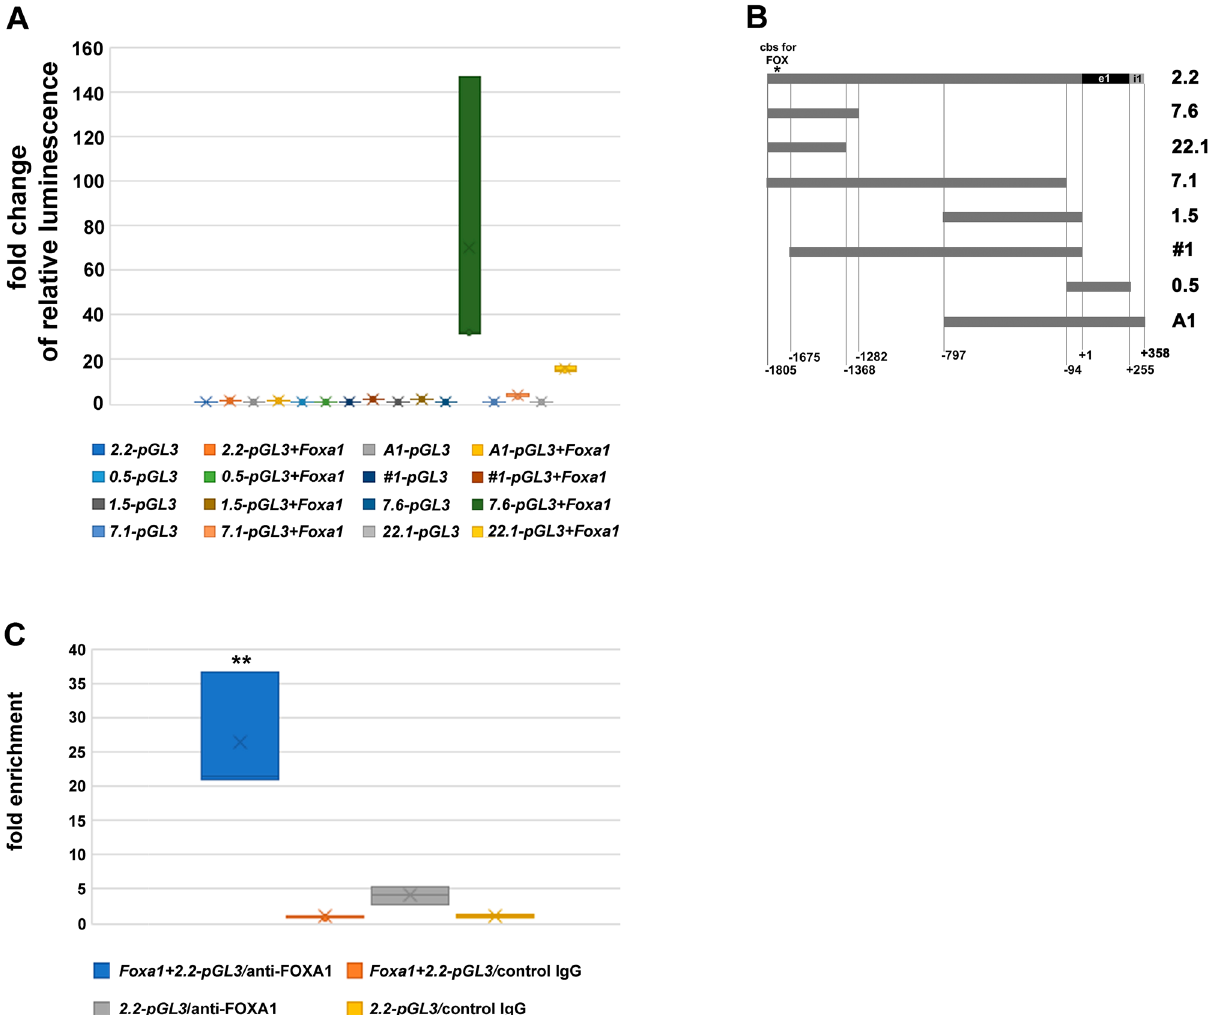
Figure 4. FOXA1 binds to the sequence TGT TTA C situated at positions -1768 to -1775 of the Odf2 promoter. ( A ) Reporter gene assay to narrow down the FOXA1-binding site. Reporter vectors comprising specific parts of the Odf2 promoter were investigated for their activation by FOXA1. FOXA1-mediated transcriptional activation was always related to that of the respective vector, without FOXA1 co-expression. The strongest activation was observed for the reporter vectors 7.6 (~ 70x), 22.1 (~ 16x), and 7.1 (~ 4x) indicating that the FOXA1-binding site is positioned in the region − 1282 to − 1805. Three biological replicates. ( B ) Scheme of the Odf2 promoter fragments cloned upstream of the firefly reporter gene (e1 = exon1, i1 = intron1). The consensus binding site (cbs) for FOX TFs is located at position − 1768 to − 1775 (*). ( C ) Chromatin immune-precipitation by FOXA1 and qPCR of the binding-site sequence revealed significant enrichment. NIH3T3 cells were transfected with the Odf2 promoter reporter vector 2.2-pGL3 as bait. Co-transfection of the Foxa1 expression plasmid ( Foxa1 + 2.2- pGL3 /anti-FOXA1) resulted in an ~ 26 × enrichment of the FOXA1-binding site compared to the control IgGs ( Foxa1 + 2.2-pGL3 /control IgG) ( p **, p = 0.007838). Precipitation of the endogenous FOXA1 by anti-FOXA1 antibodies ( 2.2-pGL3 /anti-FOXA1) caused an ~ 4 × enrichment of the binding sequence compared to the control ( 2.2-pGL3 /control IgG) that is, however, not significant ( p = Foxa1 siRNA‑mediated knockdown affects the endogenous expression of Foxa1 , Odf2 /ODF2, and CP110. Having proven an efficient reduction of FOXA1 protein by Foxa1 siRNA-mediated knockdown, we asked whether knockdown of Foxa1 could also be detected at the endogenous transcript level and whether a knockdown of FOXA1 would be accompanied by a reduction of Odf2 transcripts and also of ODF2 proteins. NIH3T3 cells were, thus, transfected with the Foxa1 siRNA, and transcripts of Foxa1 and Odf2 were quantified by qRT-PCR. We observed a reduction of Foxa1 transcripts in Foxa1 siRNA-transfected cells to ~ 0.5 × of that in control siRNA-transfected cells (Fig. 7A, p * 0.02727533). Furthermore, the reduction of Foxa1 transcripts was accompanied by a reduction of Odf2 transcripts to ~ 0.6 × compared to control siRNA-transfected cells (Fig. 7A; p *** 0.00062325). These results, therefore, indicate that transcription of Odf2 is under control of FOXA1. Finally, we quantified ODF2 proteins in lysates obtained from cells transfected with either the control siRNA or one of the Foxa1 siRNA duplexes. We observed a significant reduction of ODF2 to approximately 0.6 × when